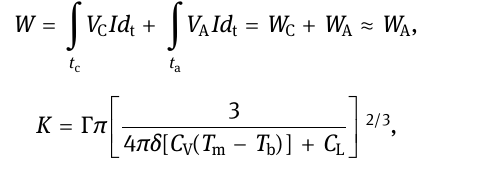
and V are the current and voltage loaded at where V A C both ends of the electrical contact material, respectively; W and W are Joule heat and arc energy, respectively; Г C A and δ represent the ultimate tensile strength of the elec - trical contact material and the density of the molten and T are the melting point material, respectively; T m b and initial temperature, respectively; and C and C are L V the melting latent heat and speci fi c heat. For the three are composites, the relative density and speci fi c heat C V almost the same. Therefore, the ratio of contact material coe ffi cient K is close to the ratio of ultimate tensile strength. Therefore, it can be concluded from the analysis is of the expression that the maximum welding force F m and the tensile strength Γ . related to the arc energy W A